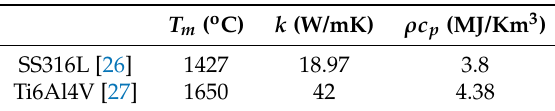
Table 1. Material